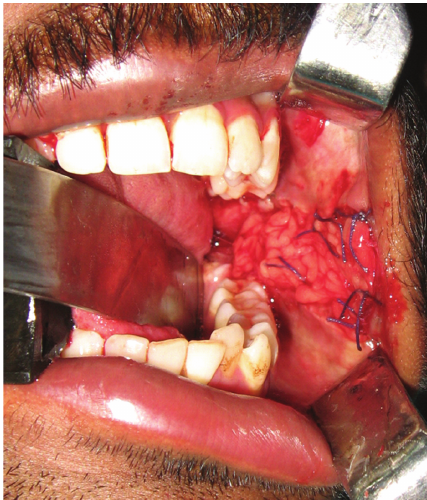
Figure 5: Buccal fat pad sutured (Intraop).